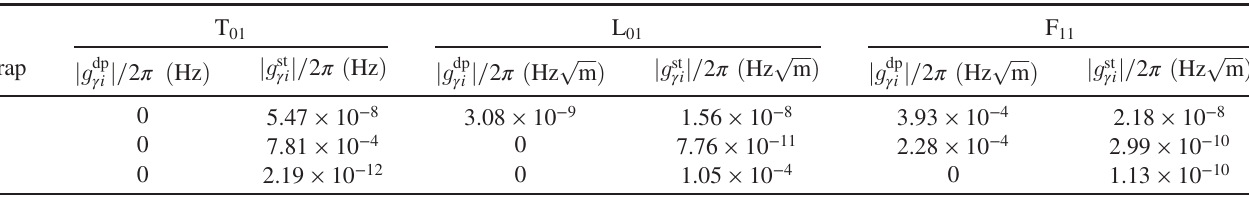
TABLE I. Atom-phonon coupling constants. Listed are the contributions of displacement (dp) and strain (st) coupling to the coupling are calculated according to Eq. (D6). The strain coupling constants g st γ are obtained constants. The displacement coupling constants g dp γ i i from Eq. (8) with the coupling functions listed in Table XVI in Appendix D. Coupling to modes on the continuous L 01 and F 11 bands is independent of the position of the trap site along the fiber axis. In contrast, the strain coupling constants to the discrete T 01 modes depend on the position since the torsional modes form standing waves, see Appendix C. Listed here are the maximal coupling constants; for radial motion, the coupling is maximal at the end of the nanofiber ( z ¼ 0 , L ), while it is maximal at the center of the nanofiber ( z ¼ L= 2 ) for the azimuthal and axial